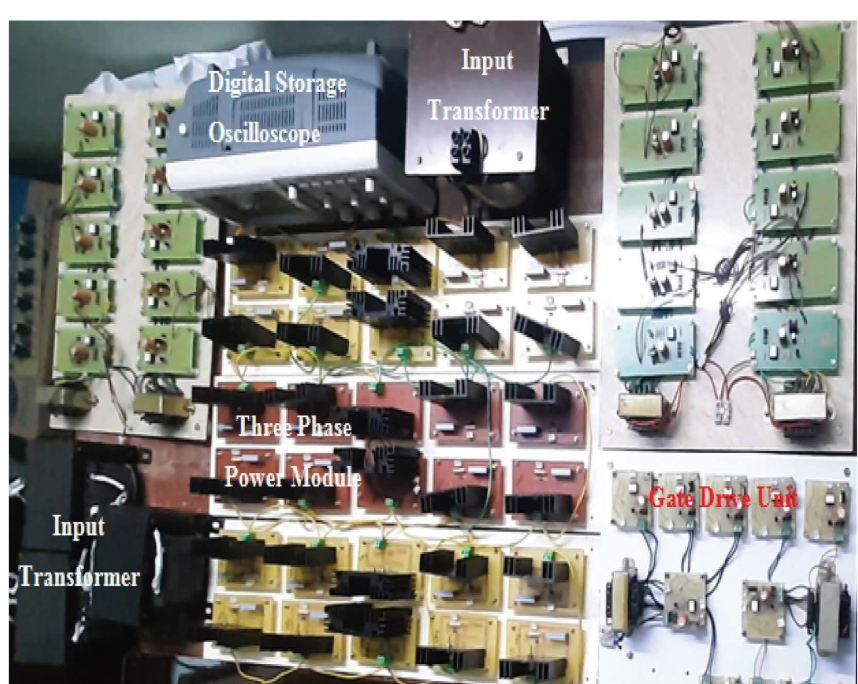
Figure 20: Experimental